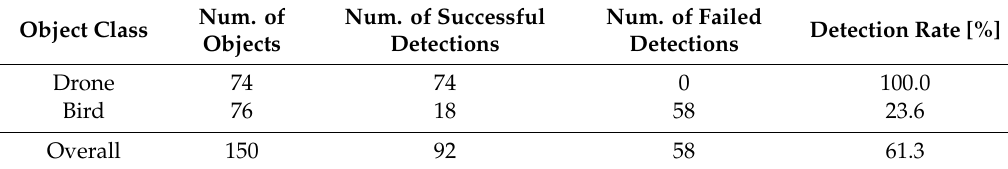
Table 4. The detection rate of the detector trained to one class (drone).